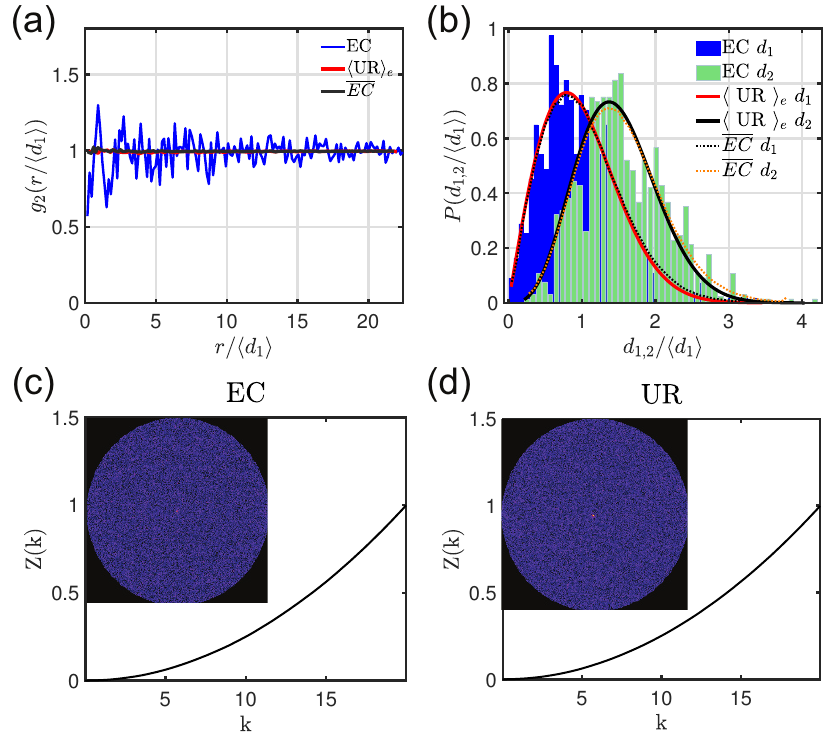
Figure 2. ( a ) Radial distribution function g ( r ) of the EC of Figure 1b (blue line) as compared to the averaged two-point correlation function of 200 different disorder realizations of Poissonian point patterns (red curve). The black line identifies the averaged g ( r ) of 900 different elliptic curves generated by all the possible combinations of the coefficients A and B in the range ( 1,30 ) . ( b ) First (blue bars) and second (pastel green bars) neighbor probability density function of the EC point pattern generated by the equation y 2 = x 3 + 27 x + 4 as compared to the Poissonian first and second neighbor distribution defined by Equation (3) [31,55]. The two dotted curves are the averaged P ( d 1 ) and P ( d 2 ) of the 900 different elliptic curves generated as explained above. Panels ( c , d ) display, respectively, the behavior of the integrated intensity function defined by Equation (5) of the elliptic curve of Figure 1b over the finite fields F 2111 and of a representative Poissonian point pattern. Insets report their structure factors S ( k ) evaluated by using Equation